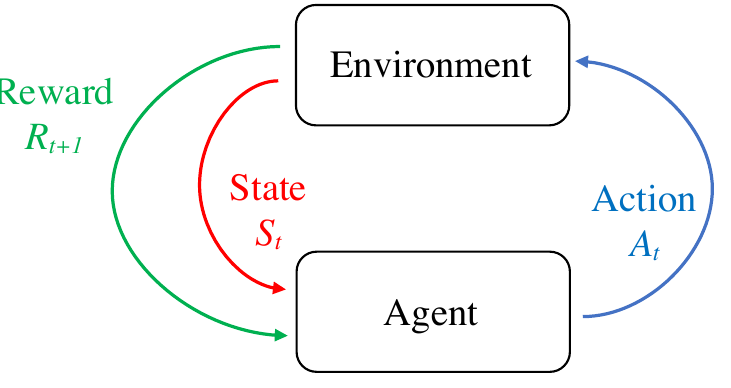
Figure 1. A diagram of the MDP